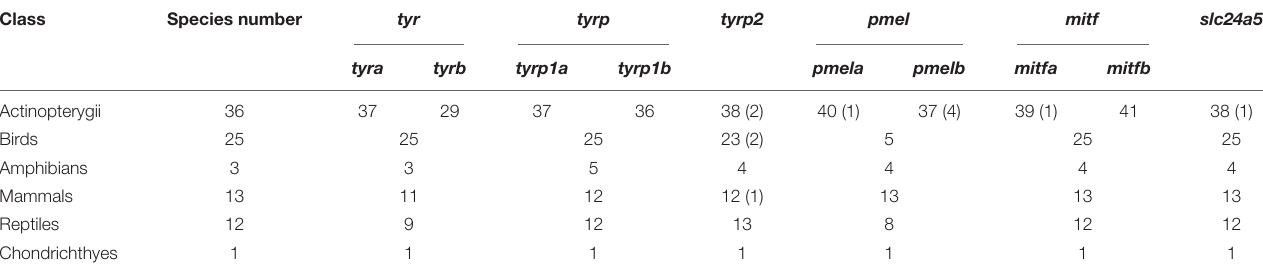
FIGURE 1 | Melanin synthesis pathway in vertebrates. The tyrosinase family ( tyr , tyrp1 and tyrp2 ) and pmel are essential for melanin synthesis. The melanosomal transporter ( slc24a5 ) and regulatory factor (mitf) are also important for proper melanin synthesis. Red indicates the genes that we analyzed in detail. This figure was modified from a previous report (Oh et al., 2017). Abbreviations: α -MSH, alpha-melanocyte stimulating hormone; creb , cAMP response element binding protein; mc1r , melanocortin receptor; pka , protein kinase A. See other abbreviations in corresponding text. TABLE 1 | Copy numbers of representative genes for melanin synthesis in 90 representative vertebrate